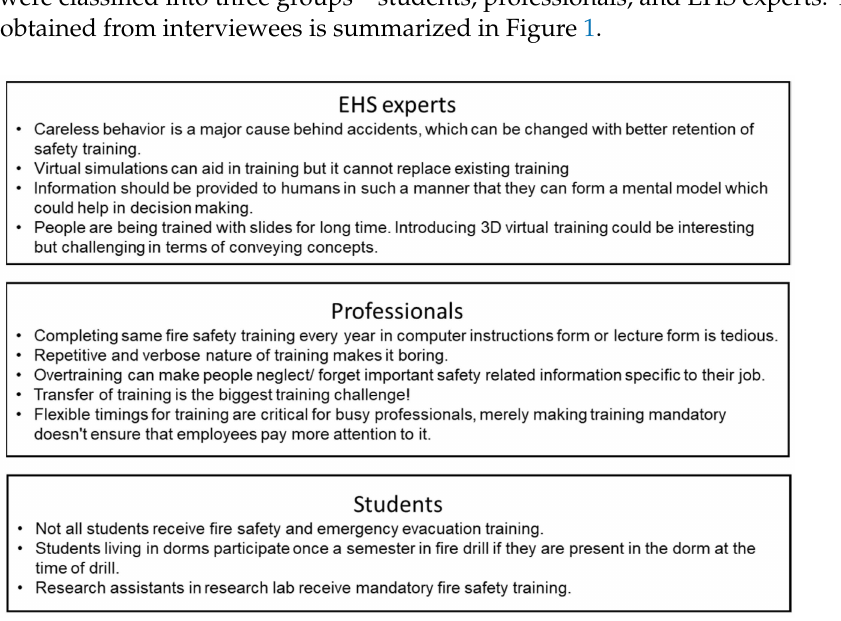
Figure 1. Learnings from the Lean Startup interview